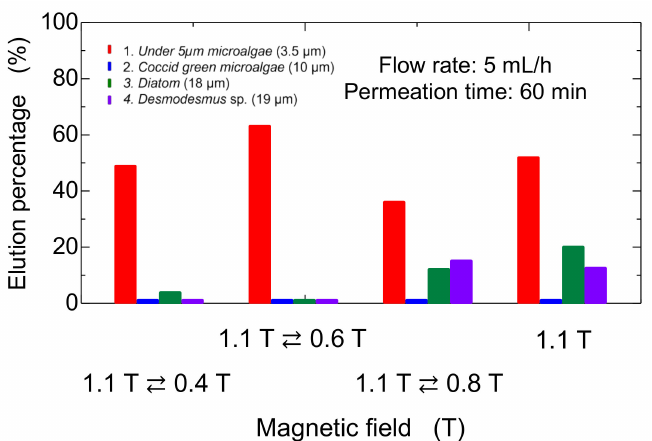
Figure 10. Dynamic elution of microalgae from Mag-gel-packed column at different magnetic